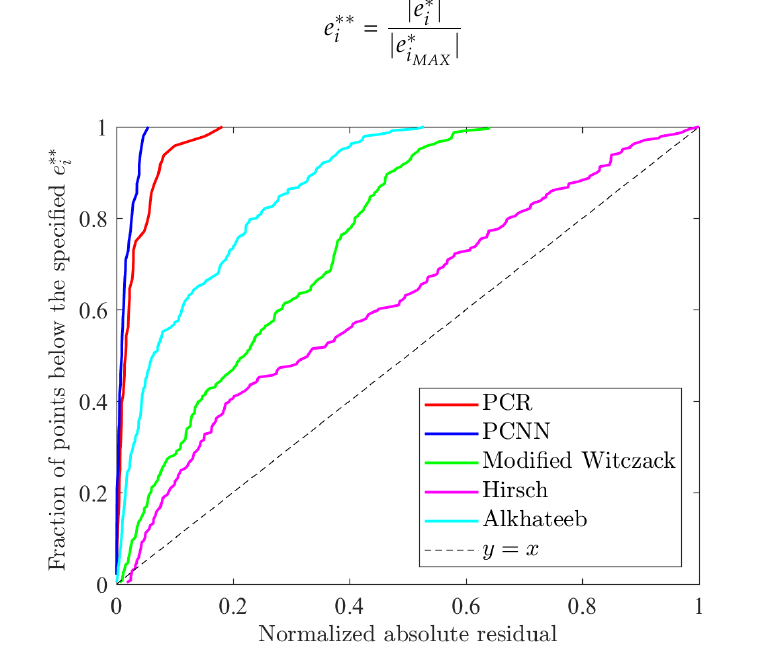
Figure 8. ROC curves for the developed and the existing predictive models for the dynamic modulus. The curves indicate the goodness of the fit provided by the models with regard to a pre-specified residual. The PCNN model showed the highest performance (farthest from the y = x line), and the Hirsch model showed the lowest (closest to the y = x